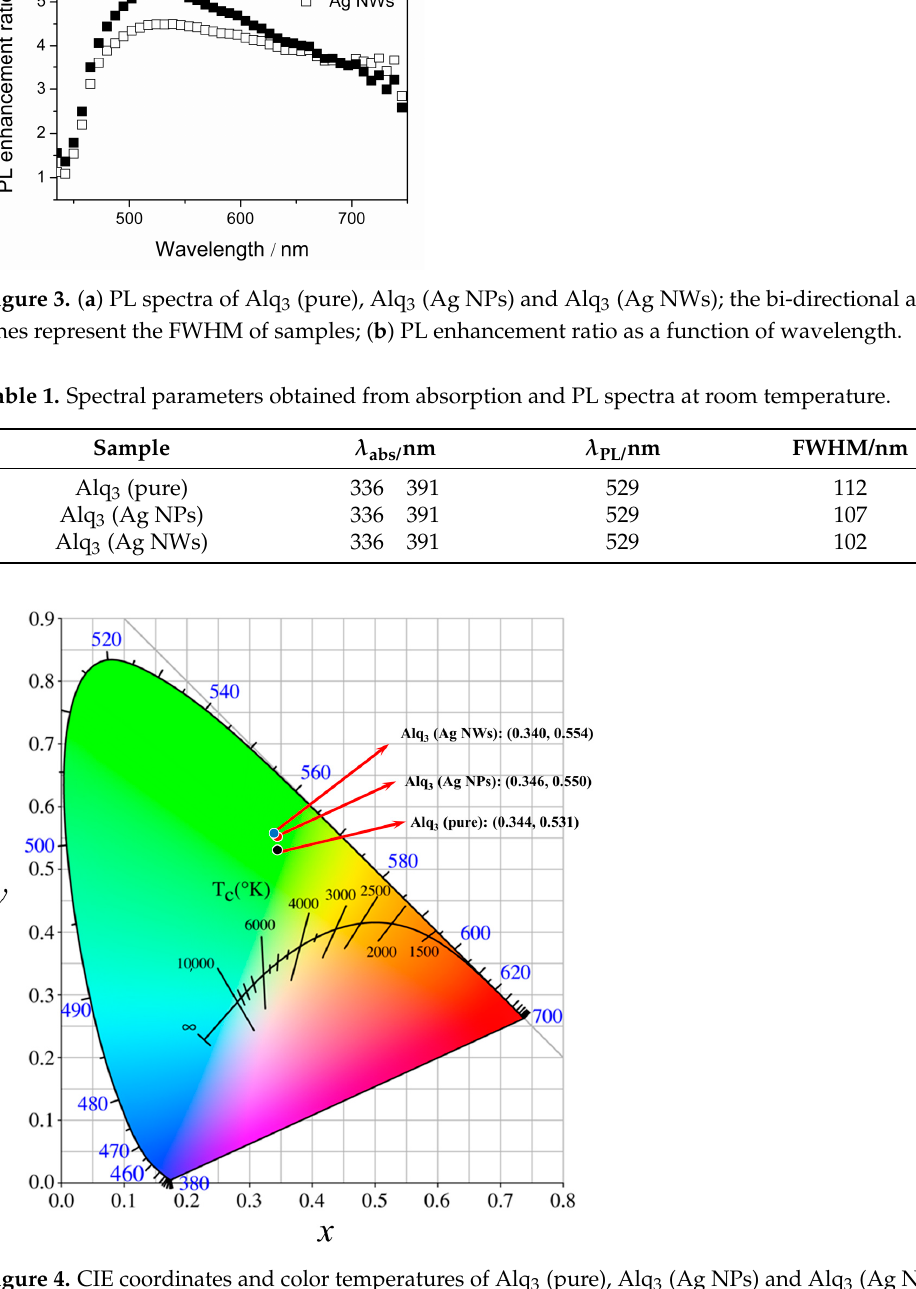
Figure 4. CIE coordinates and color temperatures of Alq 3 (pure), Alq 3 (Ag NPs) and Alq 3 (Ag NWs). In order to further explore the plasmon–exciton coupling affected by temperature, temperature-dependent PL spectra of samples in the range of 298–393 K are given in Figure 5. A decrease in PL spectra is observed with increasing temperature regardless of the absence or presence of Ag nanostructures, suggesting that at high temperatures, the electron–phonon interaction may restrain the emission from Alq 3 , resulting in increased thermal non-radiative recombination and decreased PL intensity [31,34]. Figure 5. PL spectra of ( a ) Alq 3 (pure), ( b ) Alq 3 (Ag NPs) and ( c ) Alq 3 (Ag NWs) under different temperatures from 298 to 393 K. Figure 6a shows the temperature dependence of the IPLI. The decrease of the IPLI with increasing temperature is owing to the increase of thermal disorder, which de- creases electron delocalization [35]. When the strong plasmon–exciton coupling occurs at low temperatures from 298 to 323 K, the IPLI of nanostructure-embedded composites